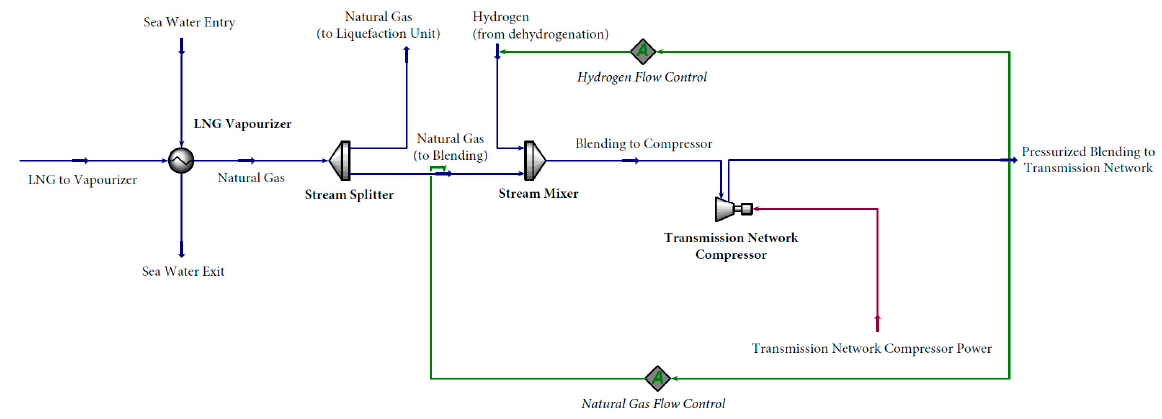
Figure 7. Simulated PFD for the hydrogen-NG blending compression stage.